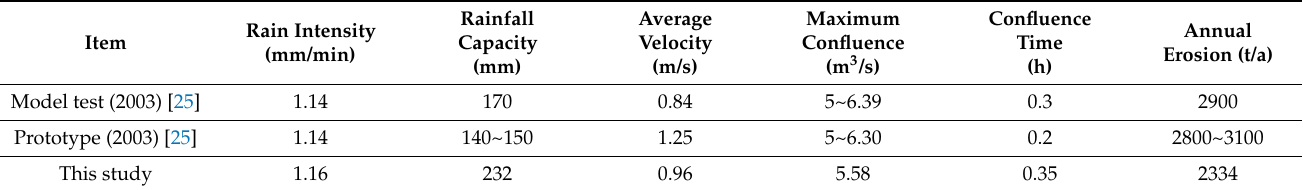
Table 6. Summary of the main scales of the small watershed model.